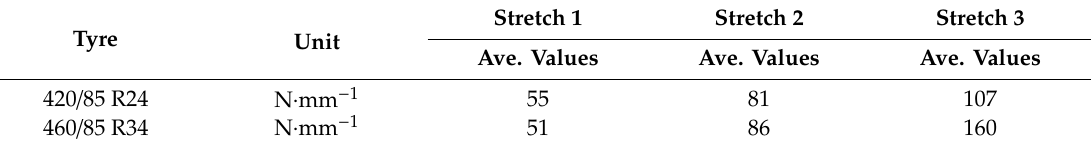
Table 3. Di ff erences between the elastic coe ffi cients at 1.0 bar and 1.6 bar in the three stretches of a loading curve in the two experimental trials for the two tyres (in N · mm − 1 ), according to Equation (1). Tyre